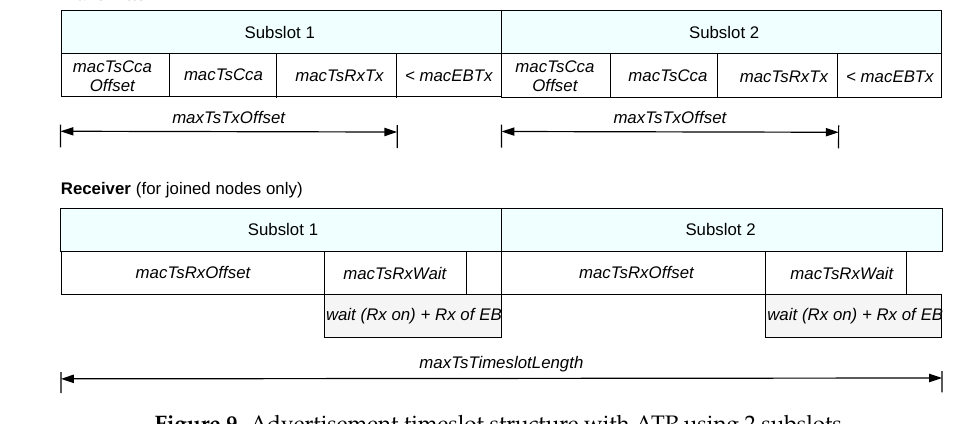
Figure 9. Advertisement timeslot structure with ATP using 2 subslots. Table 1. The attributes of the IEEE802.15.4-TSCH timeslot template.